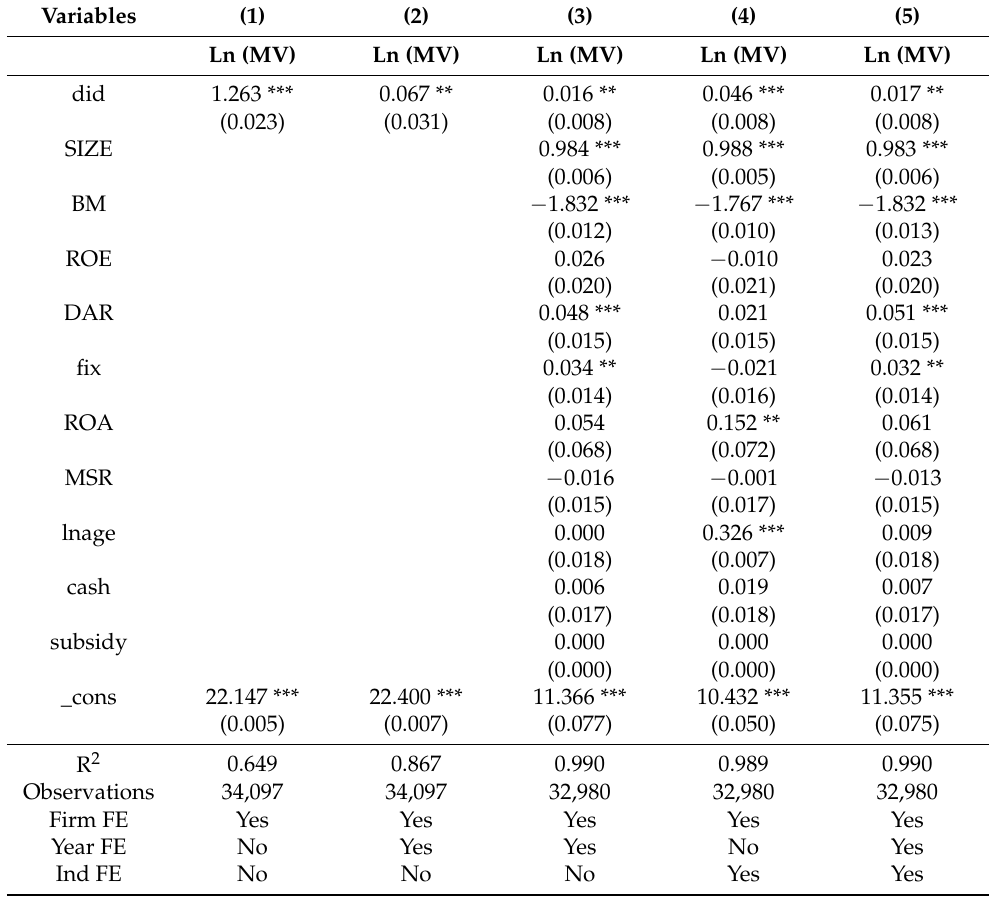
Table 4. The regression results of the effect of the pilot CET policy on companies’ market